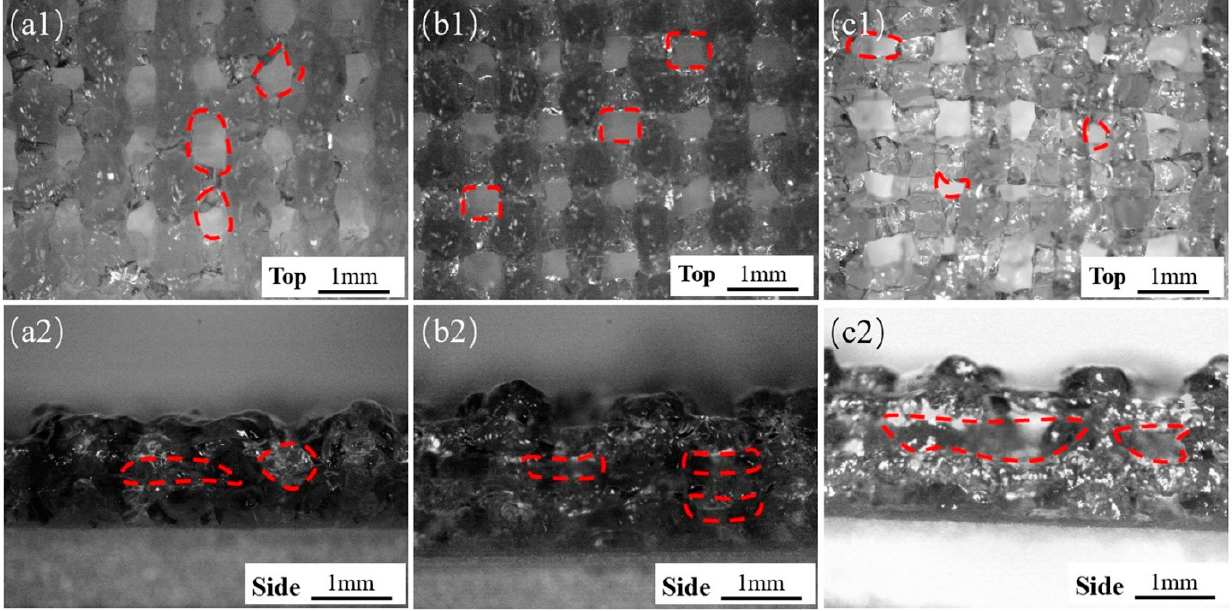
Figure 3. Shapes of the scaffolds with different layer heights under conventional extrusion printing ( a1 – c1 , top views) for Δ H of 0.3 mm, 0.4 mm, and 0.5 mm, respectively, ( a2 – c2 ) side view. We finally selected these parameters: agarose concentration = 0.5%, platform speed = 10 mm/s, extrusion velocity = 0.01 mm/s, nozzle gauge = 21 G, layer height = 0.4